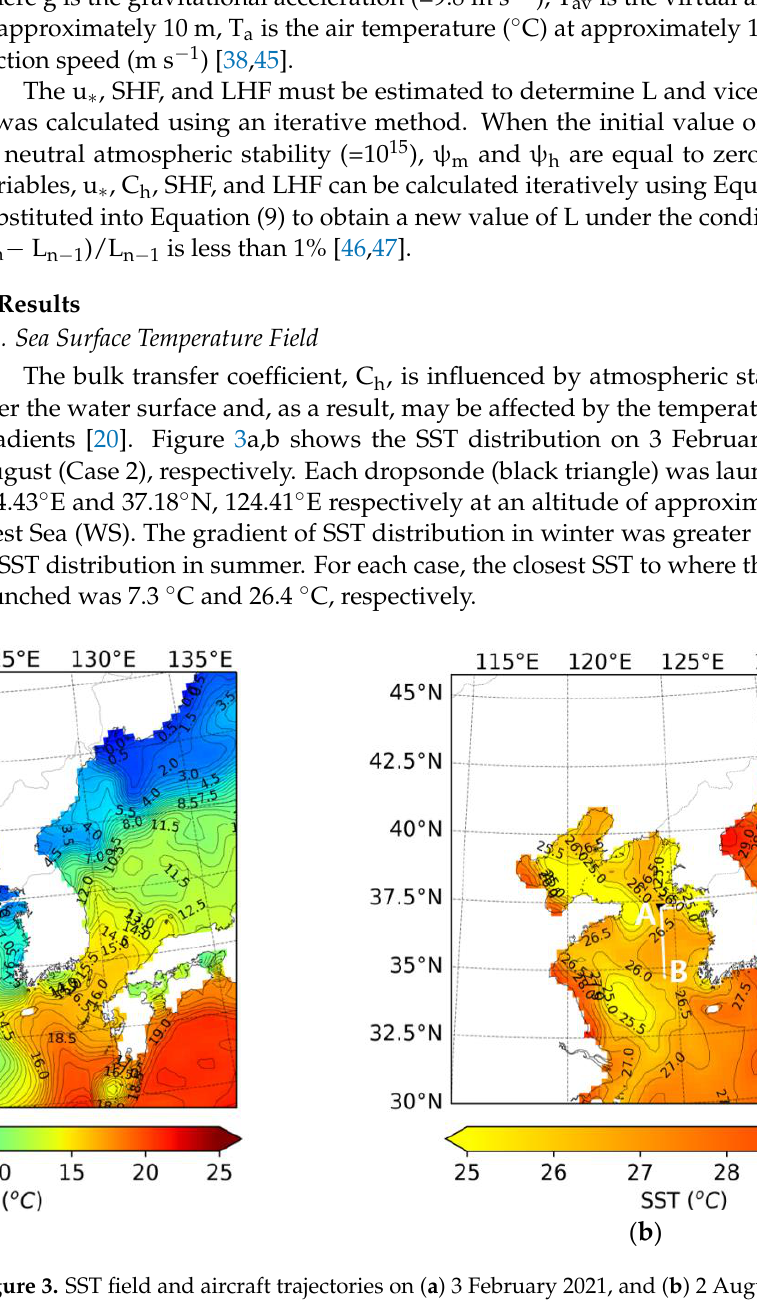
( c ) Figure 4. Variation in SST (red circle) and air temperature (blue square) along the flight path. The x-axis of ( a ) and ( b ) represents the distance from the initial launch point A of the dropsonde to the final point B over the West Sea. ( a ) 3 February 2021; ( b ) 2 August 2021; ( c ) the gradient of SST and air temperature. Figure 4c shows the scatter plot between SST and air temperature gradients in 48 cases (Table 1), except for the 21 January case (because there was only one dropsonde